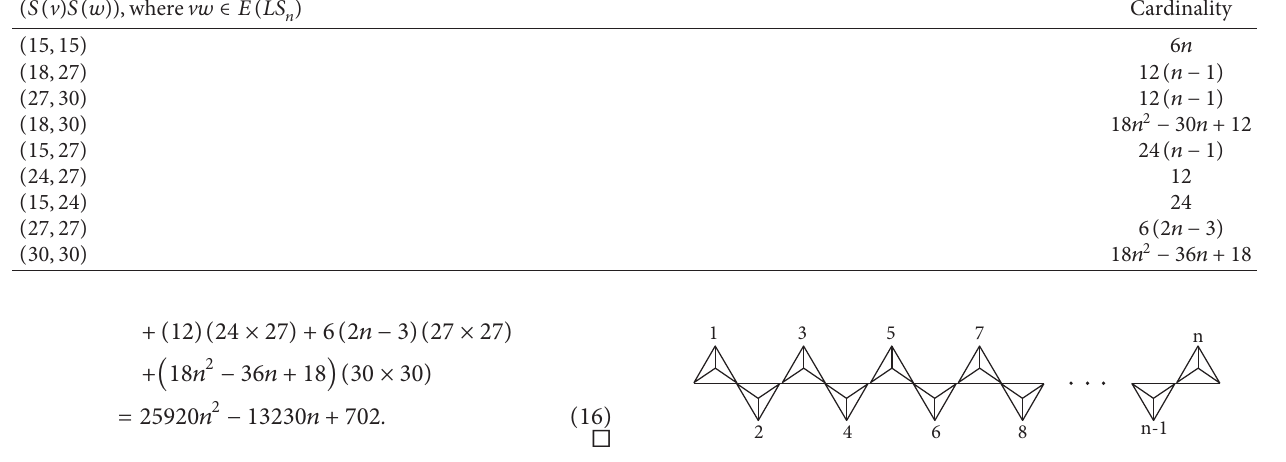
Table 3: Edge partition of LS